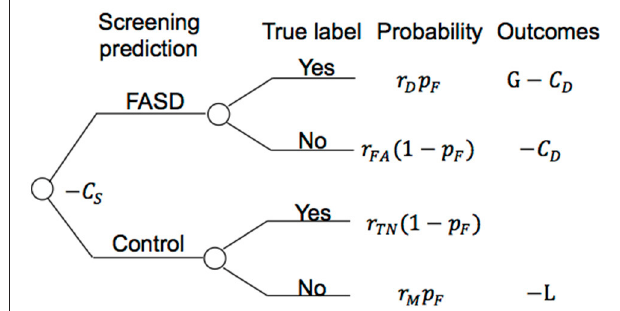
FIGURE 5 | Model structure for cost evaluation of the screening procedure. C S , screening cost; r D , detection rate; r FA , false alarm rate; r TN , true negative rate; r M , miss rate; p F , priori probability of having FASD; C D , clinical diagnostic cost; G, gain; L,